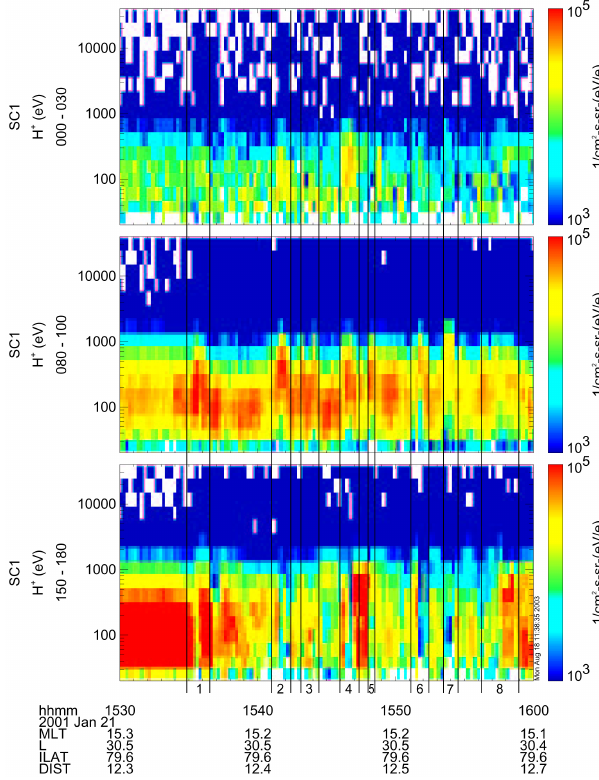
Fig. 8. Spectrograms showing the differential energy fluxes from Cluster 1 in three pitch angle bins, from top to bottom, along (pitch angle between 0 and 30 ◦ ), perpendicular (80–100 ◦ ) and antiparallel to the magnetic field (150–180 ◦ ). The flow burst times are shown by vertical guidelines. The data are consistent with the concept of tailward–convecting flux tubes passing over